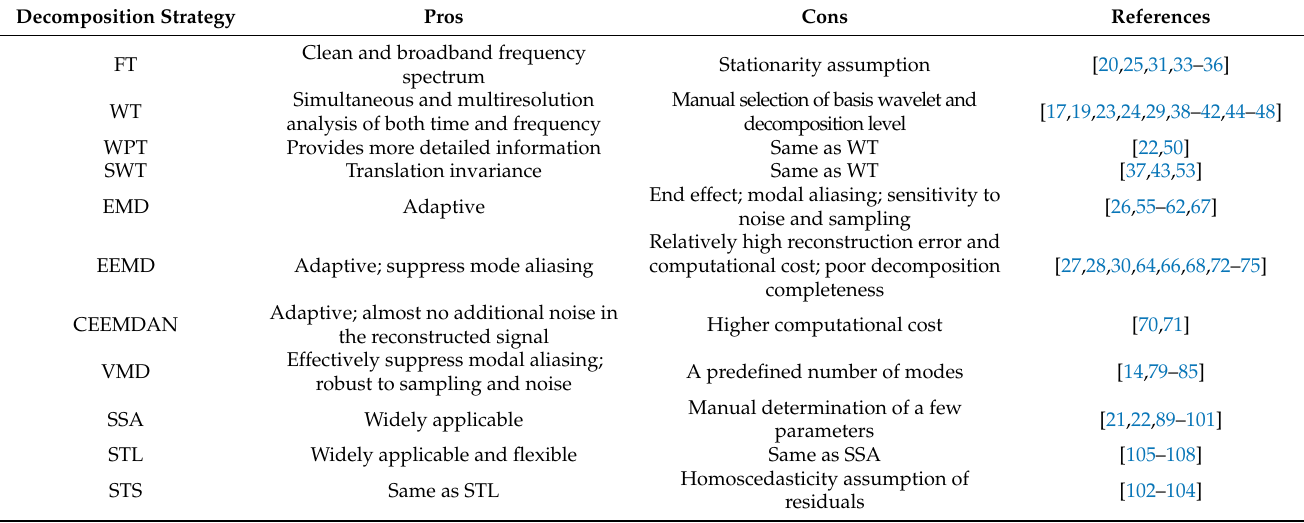
Table 1. Comparison of various decomposition